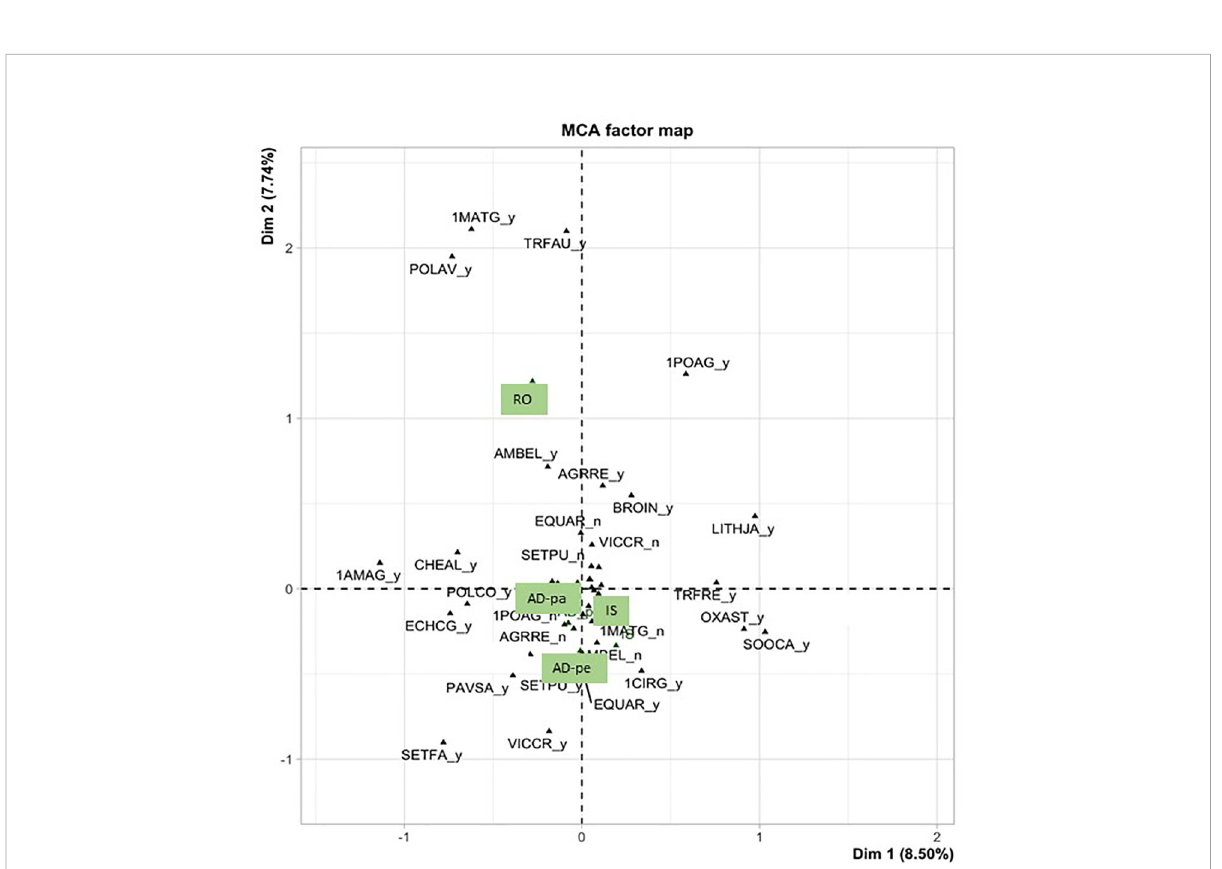
FIGURE 6 Biplot of the two fi rst components of the multiple correspondence analysis (MCA) carried out on the presence (_y) or absence (_n) of the most frequent species observed along paved roadsides (RO) and fi eld borders (AD-pa, Ad-pe and IS, see Figure 2). 1AMAG, Amaranthus sp; 1CIRG, Cirsium sp; 1MATG. Matricaria sp.; 1POAG, Poa sp; AMBEL, Ambrosia artemisiifolia ; AGGRE, Elymus repens ; BROIN, Bromus inermis ; CHEAL, Chenopodium album ; CHYLE, Leucanthemum vulgare ; ECHCG, Echinochloa crus-galli , EQUAR, Equisetum arvense ; LITHJA, Lathyrus japonicus ; OXAST, Oxalis stricta ; PAVSA, Pastinaca sativa ; POLCO, Fallopia convolvulus ; POLAV, Polygonum aviculare ; SETFA, Setaria faberii ; SETPU, Setaria pumila ; SOOCA, Solidago Canadensis ; TRFAU, Trifolium arvense ; TRFRE, Trifolium repens ; VICCR, Vicia cracca .